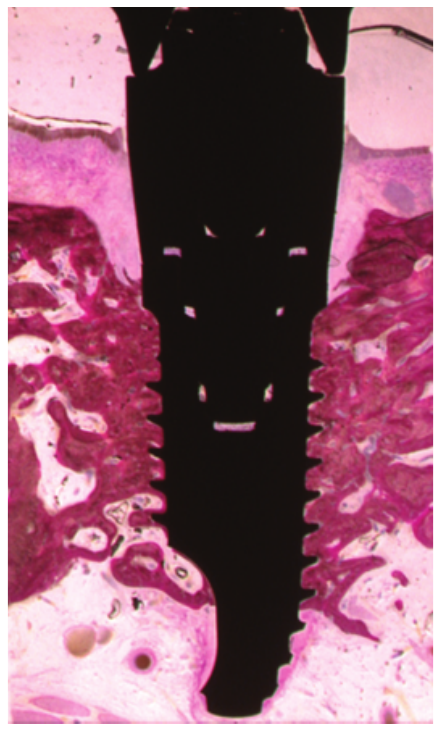
Figure 1: Histometric analysis in the percentage of bone-implant contact was evaluated. In this case, the calculated percentage was